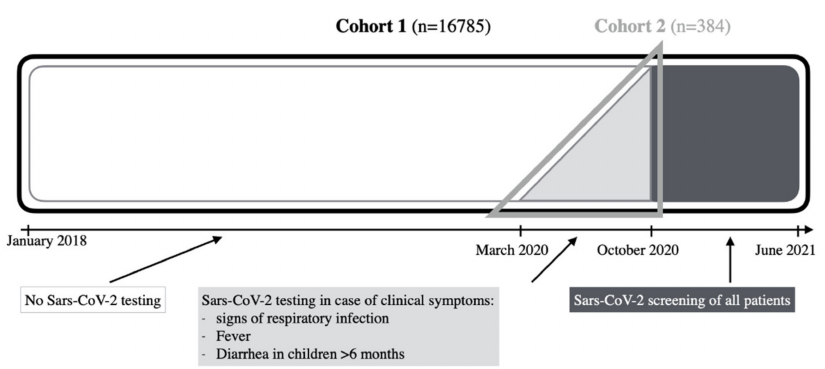
Figure 1. Overview of 2 distinct cohorts of pediatric patients admitted to our clinical center in our study. The retrospective analyses involved 16,785 pediatric patients hospitalized in our center between January 2018 and June 2021 (cohort 1, n = 16785). SARS-CoV-2 testing was